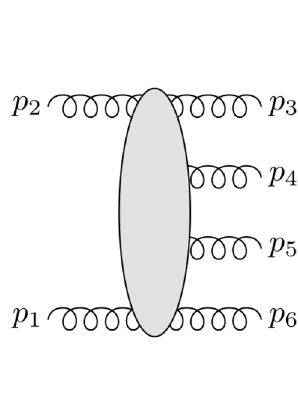
Figure 11 . Depiction of the production of four gluons of momenta p i , i = 3 , 4 , 5 , 6 , in the scattering between two partons of momenta p